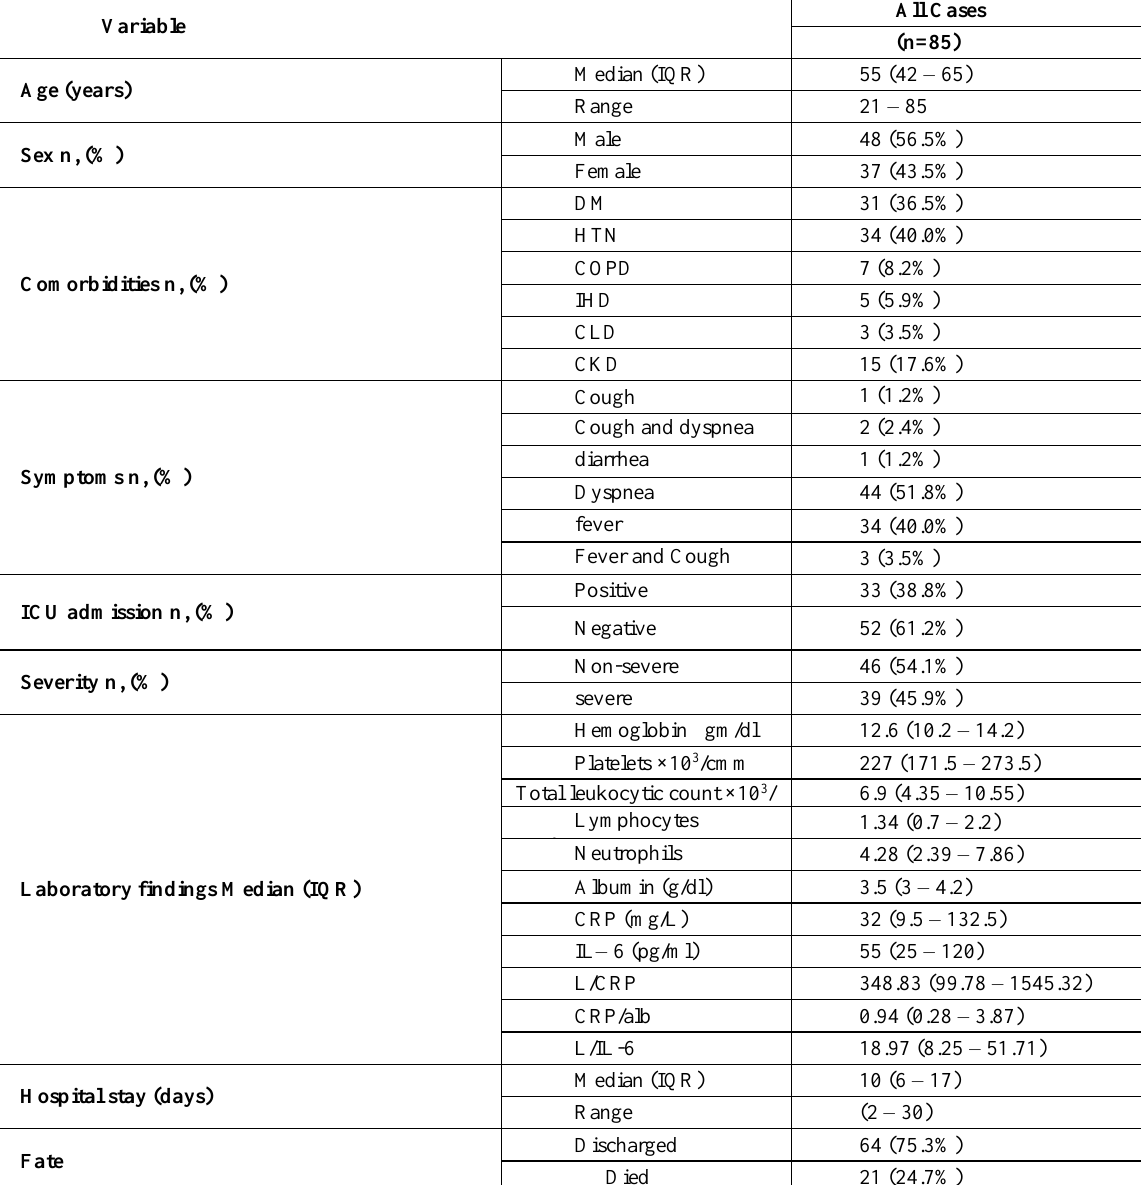
CKD: Chronic kidney disease; CLD: Chronic liver disease; COPD: Chronic obstructive pulmonary disease; DM: Diabetes mellitus; HTN: Hypertension; ICU: Intensive care unit; IHD: Ischemic heart disease; IQR: interquartile